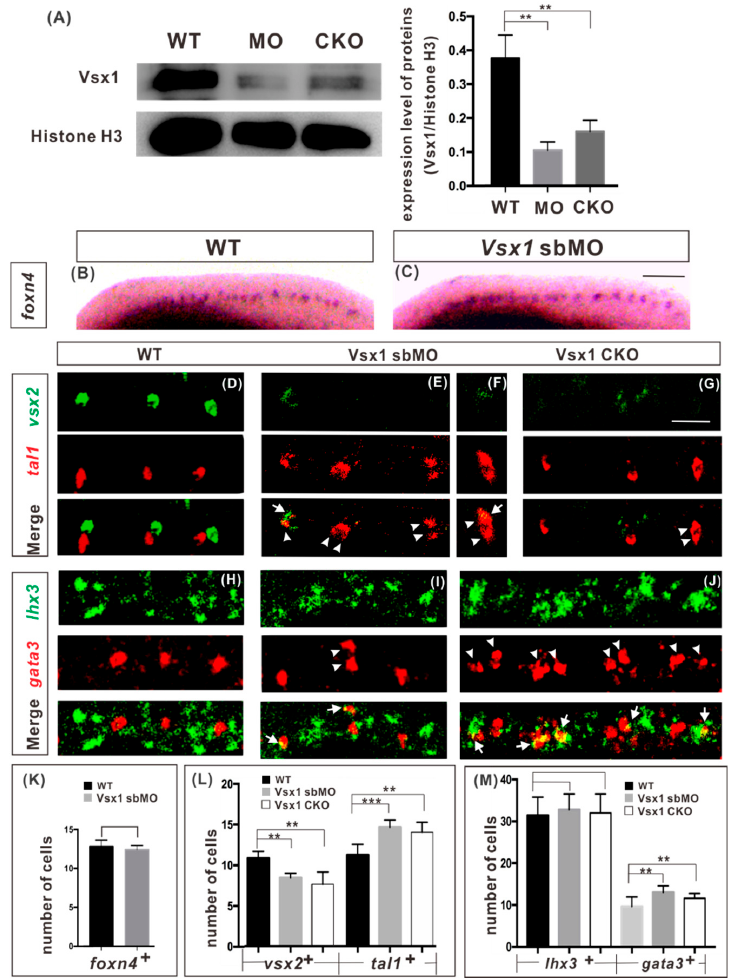
Figure 1. Zygotic Vsx1 is essential for preventing tal1 expression in presumptive V2a cells. ( A ) Western blot analysis of vsx1 sbMO knockdown and CRISPR/Cas9 transient knock out efficiency in 24hpf zebrafish embryo. * p ≤ 0.05, ** p ≤ 0.01. WT: wild type, MO: morpholino, CKO: chimeric knock out. ( B,C ) In situ hybridization of P2 progenitor marker foxn4 in the wide type ( B ) and zygotic vsx1 knockdown ( C ) embryos at 18 hpf. ( D–G ) Fluorescent double in situ hybridization of vsx2 (green) and tal1 (red) at 20 hpf in the wild type ( D ), zygotic vsx1 knockdown ( E,F ) and vsx1 chimeric knockout G0 ( G ) embryos. The expression of vsx2 was repressed but the expression of tal1 was detected in two cells ( E,F ) in some segments of zygotic vsx1 knockdown embryos. The same repression of vsx2 and ectopic expression of tal1 was detected in vsx1 chimeric knockout G0 embryos ( G ). ( H–J ) Fluorescent double in situ hybridization of lhx3 (green) and gata3 (red) at 20 hpf in the wild type (H), zygotic vsx1 knockdown ( I ) and vsx1 chimeric knockout G0 ( J ) embryos. gata3 ectopic expression and lhx3-gata3 co-expressing cells were detected in zygotic vsx1 knockdown ( I ) and vsx1 chimeric knockout embryos ( J ). White arrow heads indicate tal1 -expressing cell. White arrows indicate tal1 and vsx2 co-expressing cells. The injected reagents are indicated at the tops of images and makers are indicated on the left sides of images. Dorsal is upwards; anterior is leftwards. Scale bars: 100 μ m in B-C, 12.5 μ m in D-J. ( K–M ) Quantification of marked neurons number. Counts of foxn4, vsx2, tal1, lhx3, gata3 -expressing cells were derived from both sides of spinal cord above the yolk extension over a five-somite distance. Data in wild-type (black), sbMO knockdown (gray) and chimeric knockout (white) are presented as means ± SEMs from 10 embryos from at least two independent experiments. Statistical significance was assessed using the unpaired two-tailed Student’s t-test. ** p ≤ 0.01, *** p ≤ 0.001.